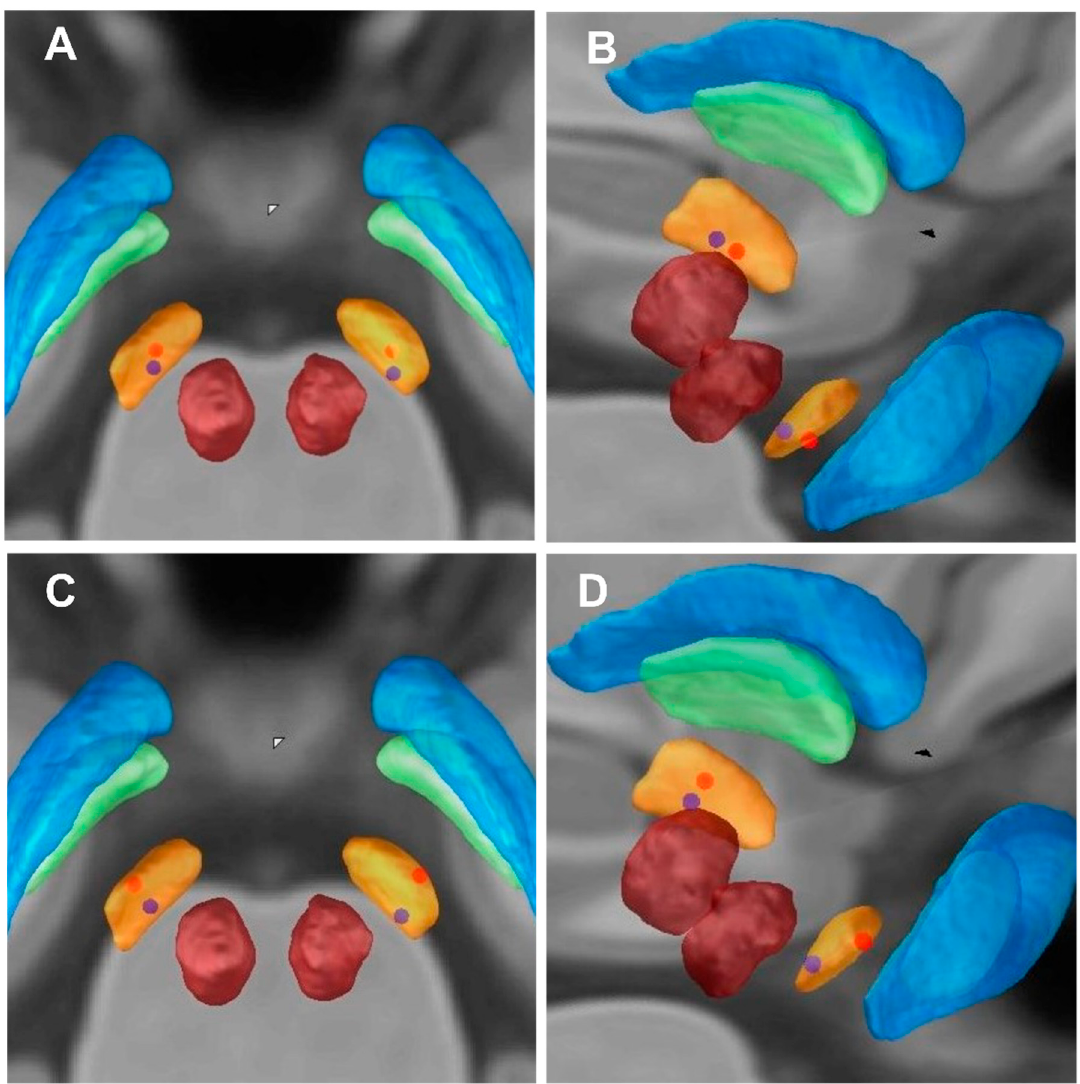
Figure 3. Imaging of electrode contacts. ( A , C ) Imaging of electrode contacts (posterior view). ( B , D ) Imaging of electrode contacts (right posterior view). ( A , B ) the Z-axes of active contact locations of an individual patient (blue dots) with lower HAM-A improvement rate (9.09%); the Z-axes of active contact locations of an individual patient (red dots) with higher HAM-A improvement rate (78.26%). ( C , D ) the Z-axes of active contact locations of an individual patient (blue dots) with lower HAM-D improvement rate (0%); the Z-axes of active contact locations of an individual patient (red dots) with higher HAM-D improvement rate (66.67%). Table 3. Correlation between HAM-A, HAM-D scores improvement rate and the VTAs. HAM-A Improvement HAM-D Improvement